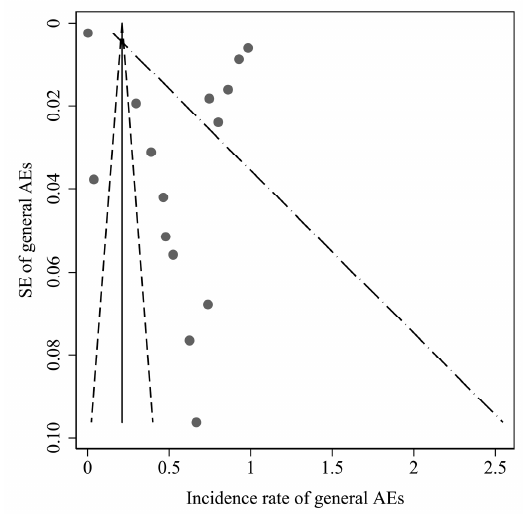
Figure A1. Funnel plot of AEs incidence rate of mRNA vaccine in observational study. For observations of viral vector vaccine and inactivated vaccine were under 10, funnel plots were not used.